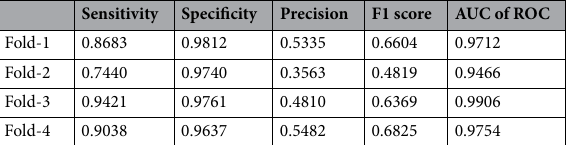
Table 4. Sensitivity, specificity, precision, F1 score, and AUC of ROC of fourfold cross